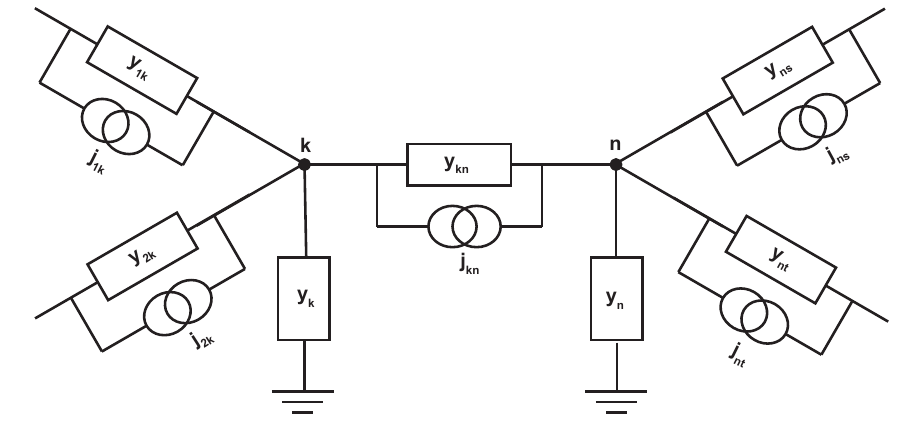
Fig. 5. Modelling GIC using the Nodal Admittance